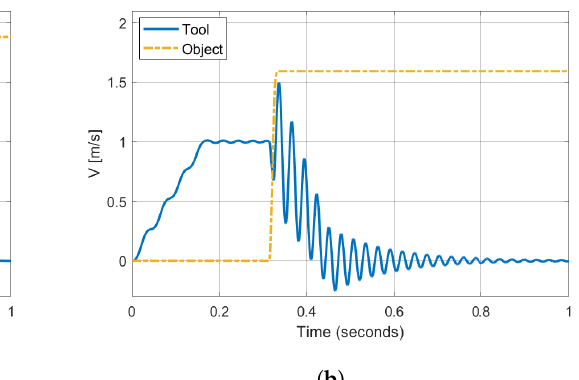
; ( b ) k c = 10 6 N m 1.5 m 1.5